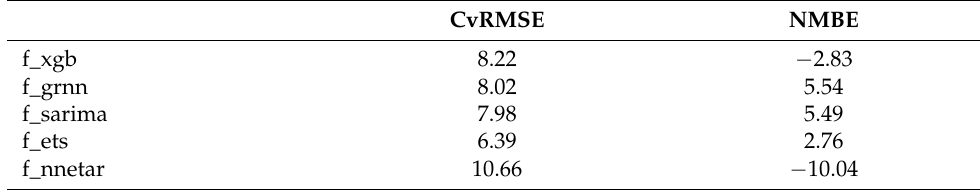
Table A4. Quarterly forecast error measure (in %).